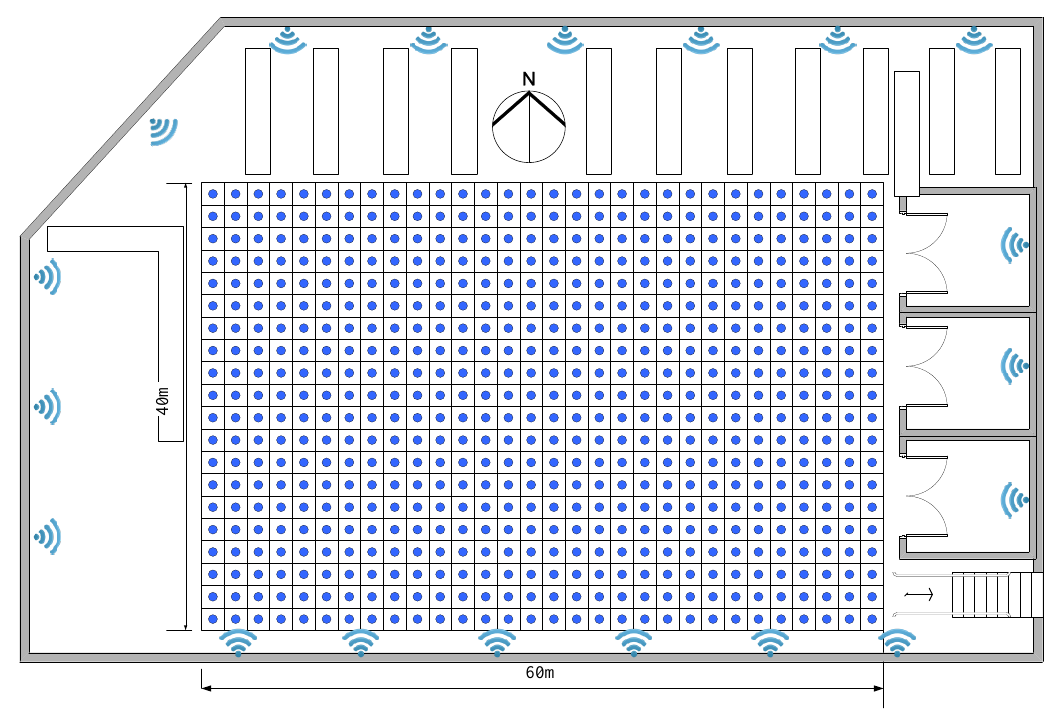
Figure 5. The layout of the library area.